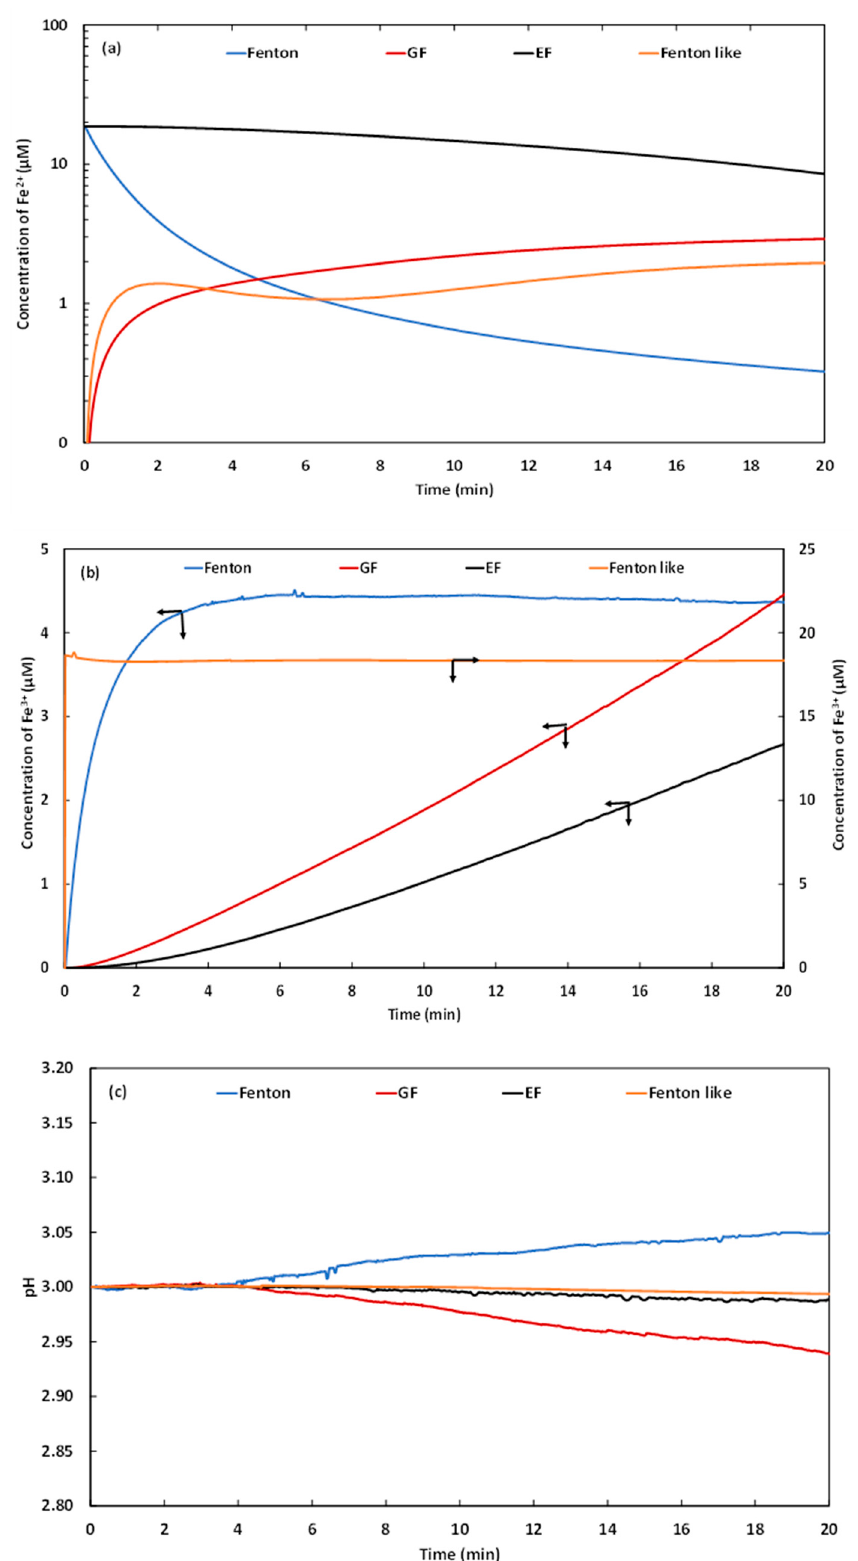
Figure 2. Evolutions of the Fe 2 + ( a ) and Fe 3 + ( b ) concentrations and the pH of the electrolyte ( c ) in a function of time with classic Fenton, Fenton-like, electro-Fenton, and Galvano-Fenton processes in the presence of phenol at 2 µM.